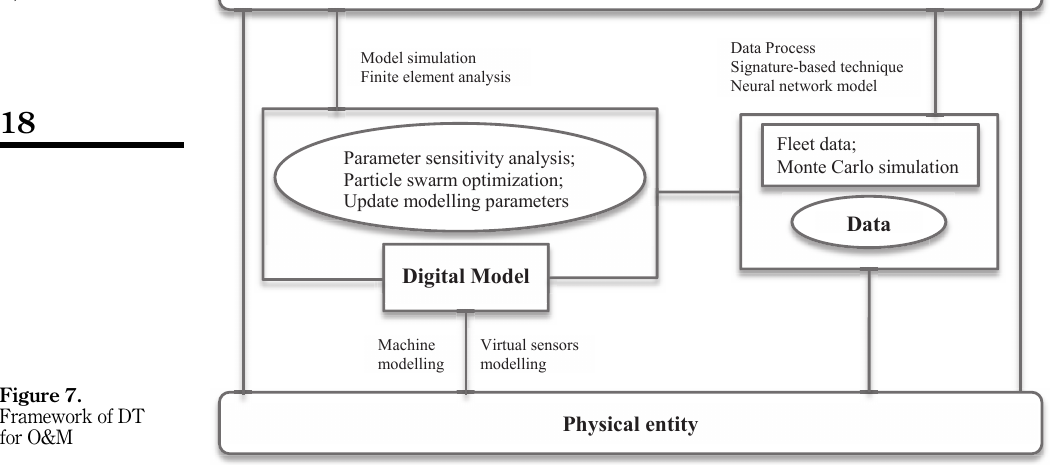
Figure 7. Framework of DT